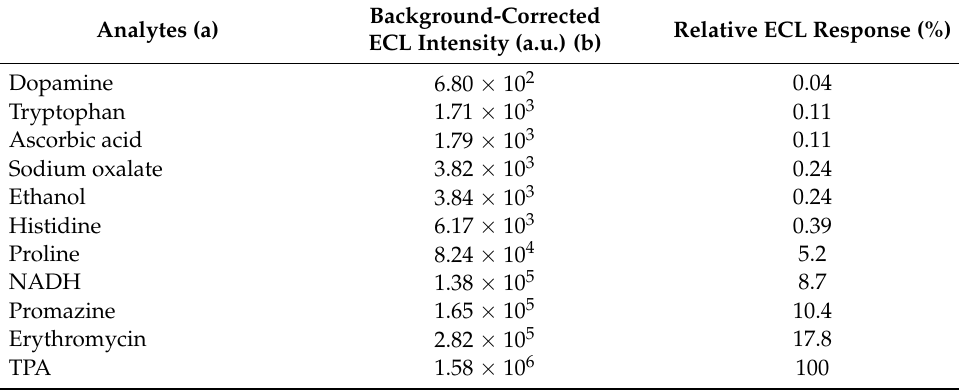
Table 2. Selectivity study on ECL responses for various analytes. Analytes